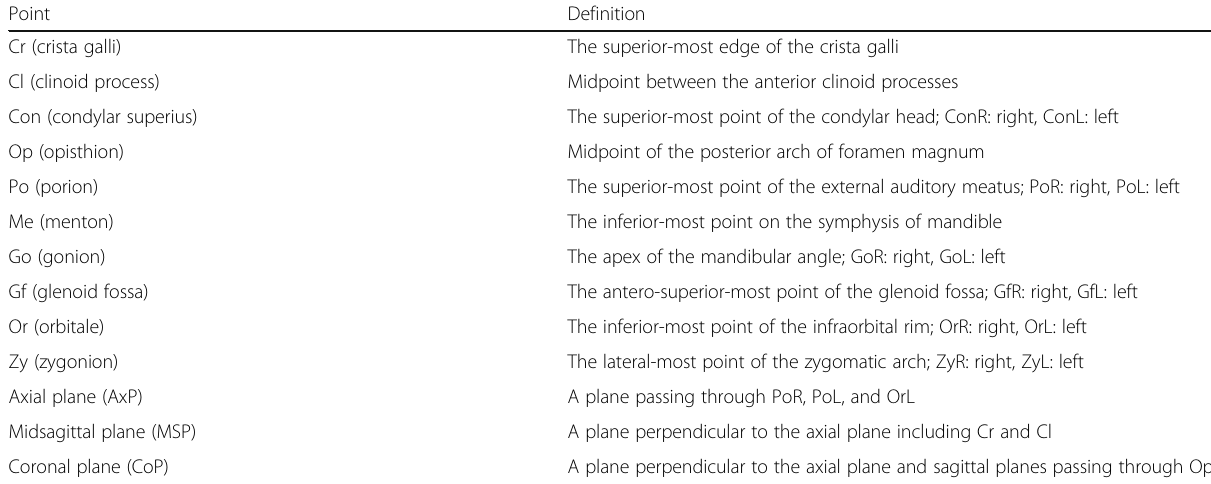
Table 1 Description of craniofacial landmarks and reference planes